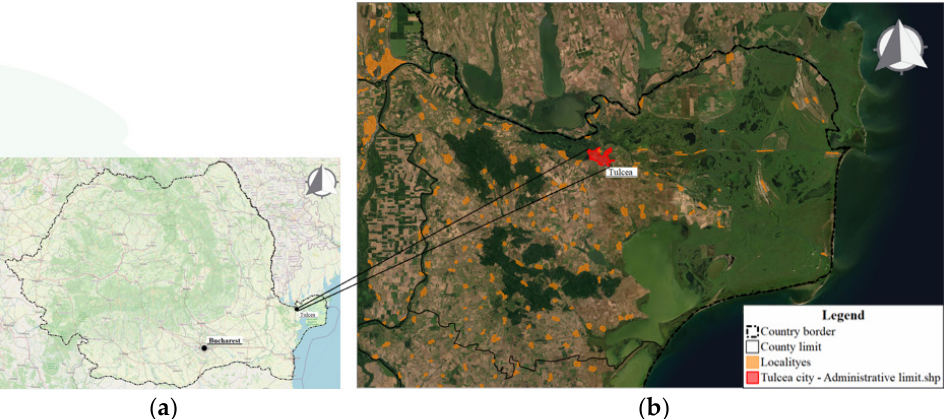
Figure 1. Location of the Tulcea municipality: ( a ) country level; ( b ) county level.